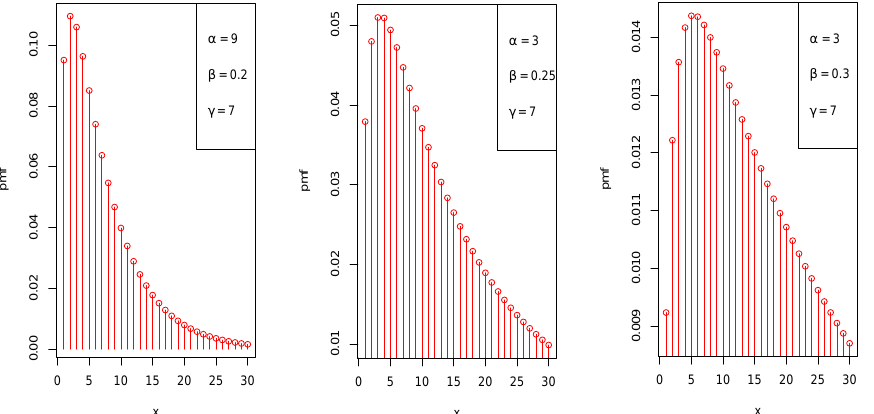
Figure 1. Various shapes of the probability mass function (pmf) of the LZTBD for different values of the parameters.